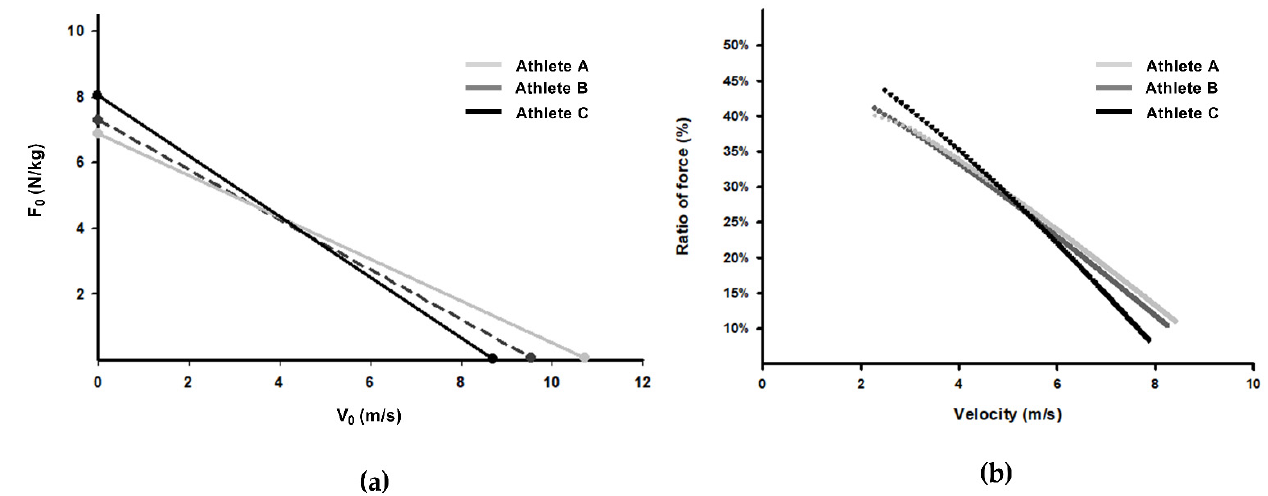
Figure 1. Sprint force-velocity profile mechanical variables from three different athletes with almost similar T_20 m time but different change of direction performance. ( a ) Sprint FV profiles (F 0 -V 0 relationship) of three athletes; ( b ) Individual ratio of horizontal force application during linear sprinting. F 0 , theoretical maximal force; V 0 , theoretical maximal velocity; T_20 m, time in 20 m.